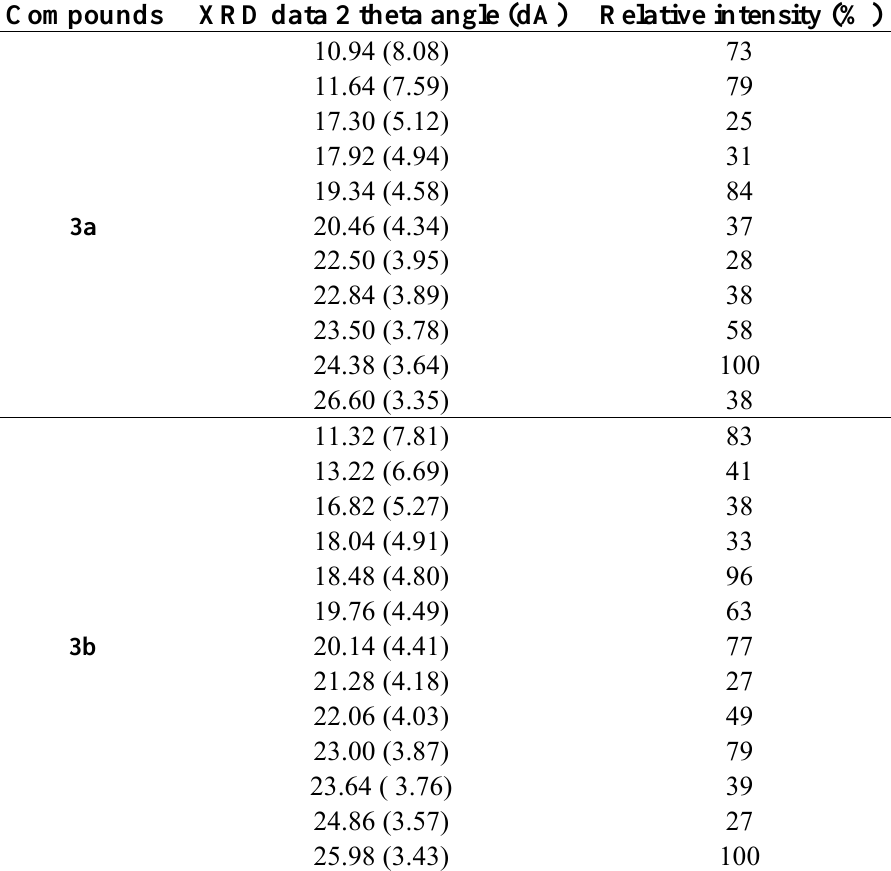
Table 2. XRD data 2 theta angle and relative intensity of 3a and 3b .